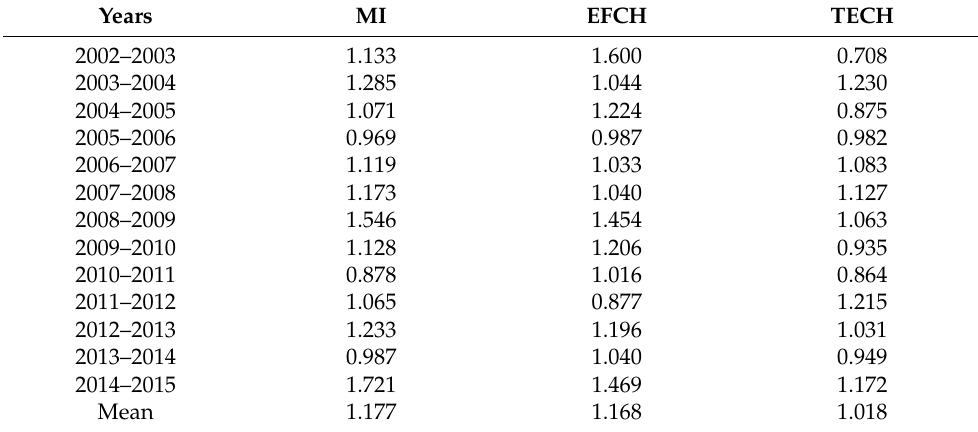
Table 3. Annual differences of the MI and its decomposition from 2002 to